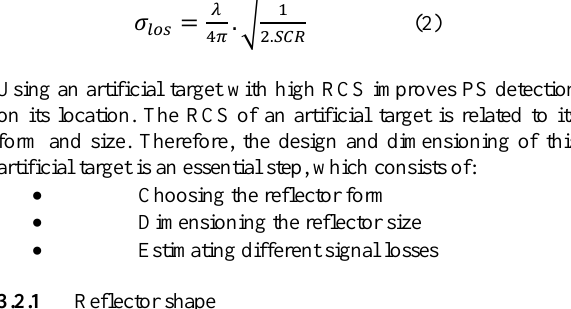
Figure 3. Home-made bilateral corner reflector co-located with